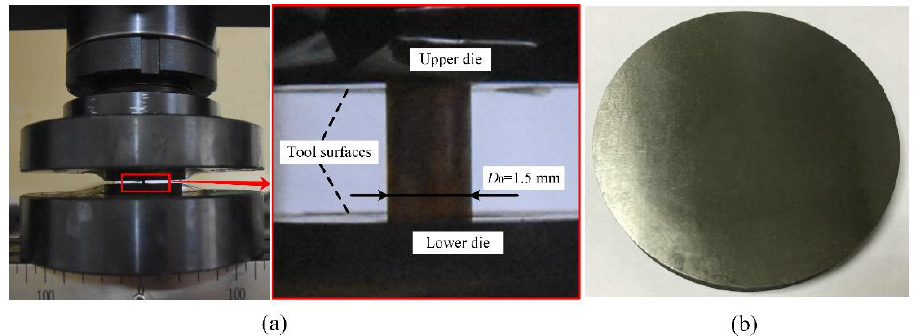
Figure 17. The micro-upsetting experiment with ( a ) experimental setup and ( b ) gasket surface.